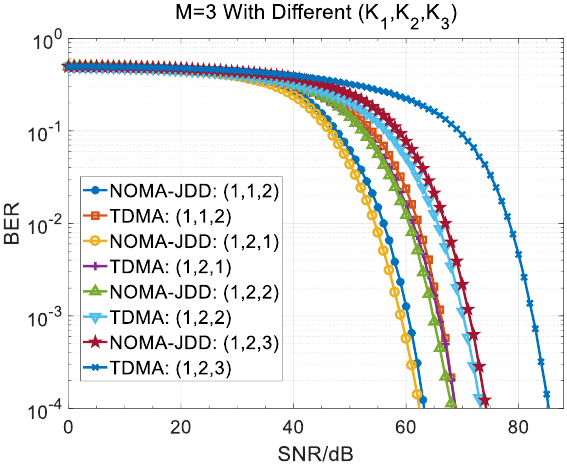
Figure 5. Three users’ average BER comparisons of our design and TDMA.